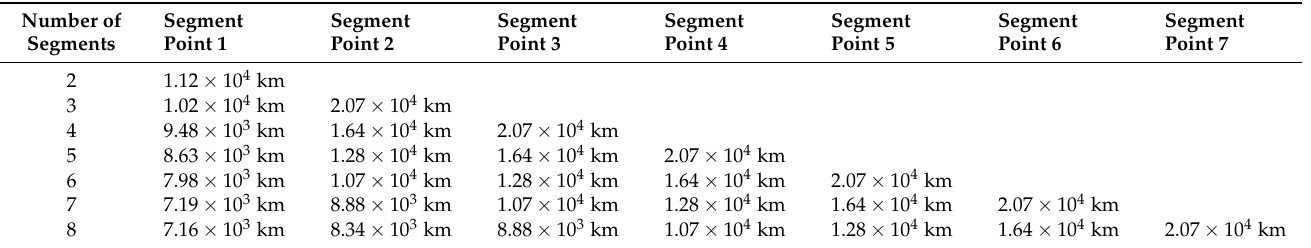
Table 5. Optimization results of rope section points of segmented space elevator